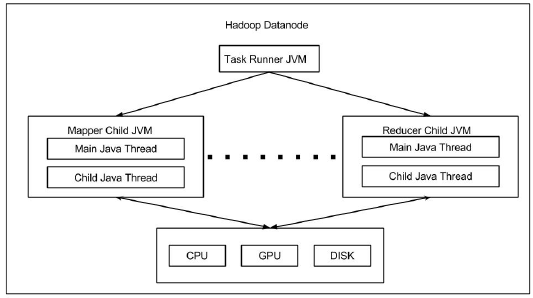
Fig. 2. Hadoop MapReduce on one Data Node Each child JVM is assigned one chunk of key- value pairs for either Map or Reduce